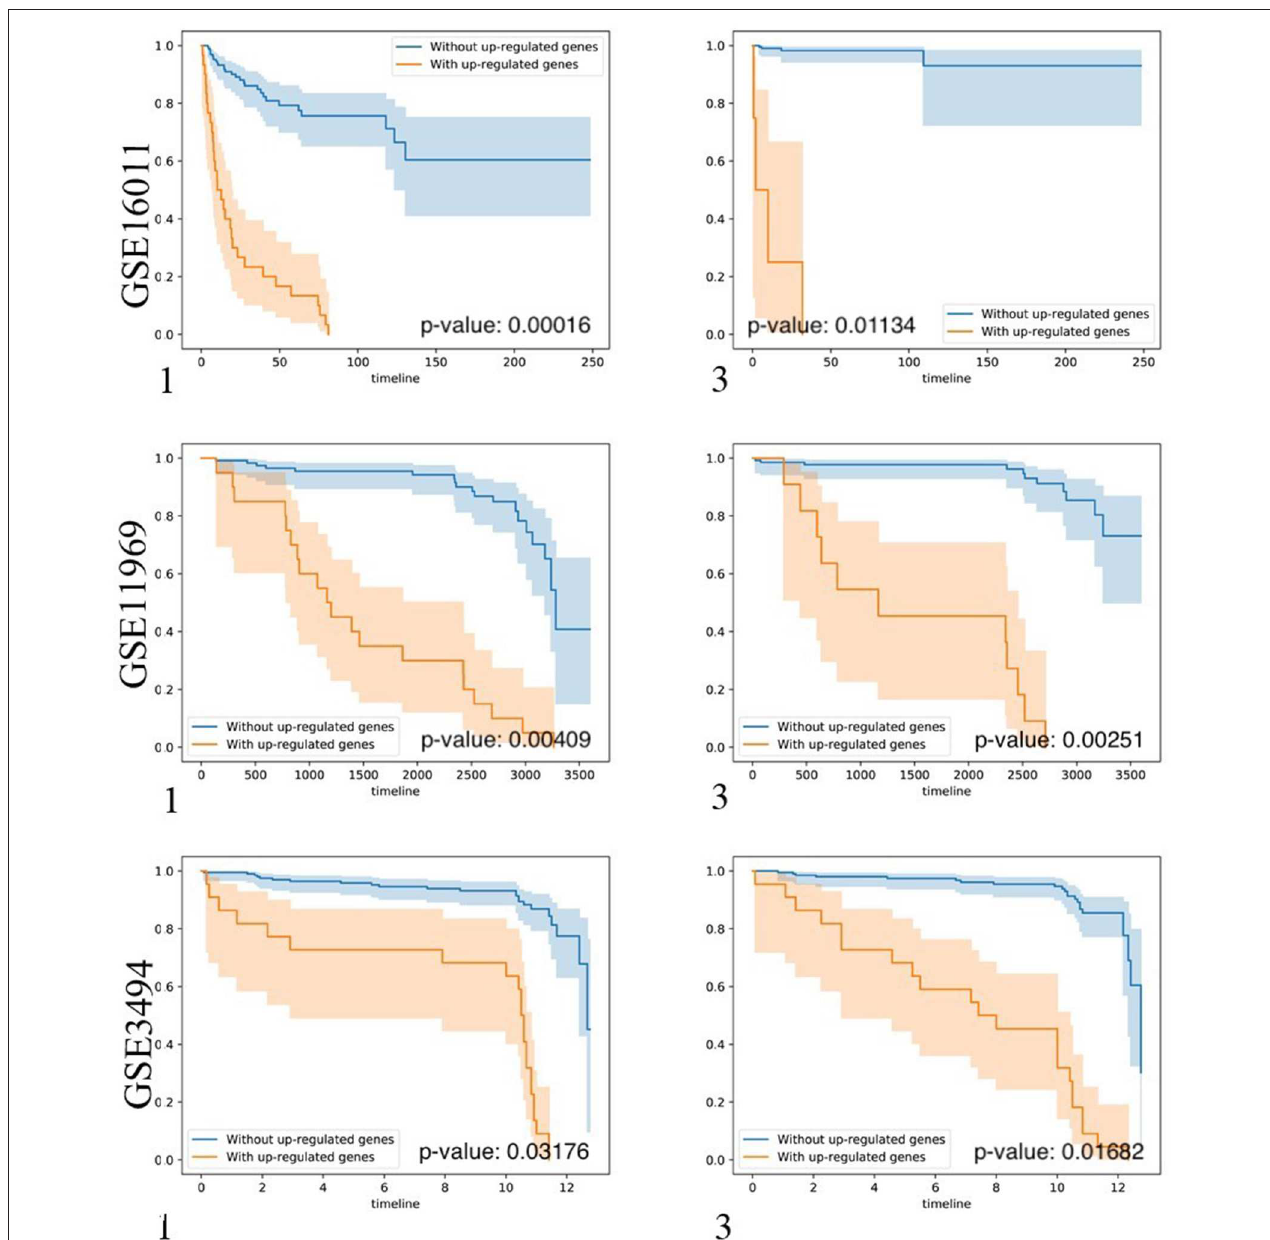
FIGURE 5 | Kaplan-Meier plots of the survival analysis of the samples from brain lower grade glioma (GSE16011), lung adenocarcinoma (GSE11969), and breast invasive carcinoma (GSE3494) patients. 1, 3 means the first and the third top-ranked biomarker gene sets detected by BISG with corresponding cBioPortal datasets. The patients were separated into two groups according to the expression profiles of biomarker genes in the selected biomarker gene set. These genes provided the best split between patients of high and low risk based on their expression levels. In the case of genes in biomarker gene sets (labeled in brown) the over-expression is correlated with poor survival (only up-regulated genes were considered); and in the case of patients without biomarker genes (labeled in blue) the over-expression is correlated with good survival. In all cases the adjusted p -values of the analyses are highly significant, indicating that the two populations represented by the two curves have a very clear difference in their overall